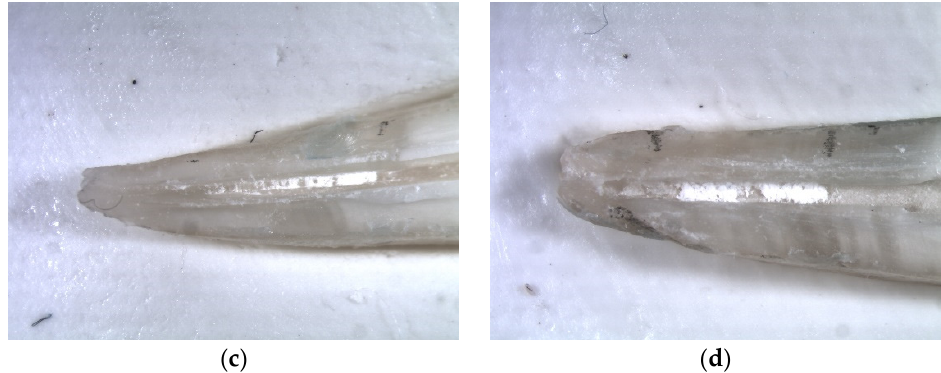
Figure 3. ( a ): Score 0: 0–25% of the groove filled with debris; ( b ) Score 1: 26–50% of the groove filled with debris; ( c ): Score 2: 51–75% of the groove filled with debris; ( d ) Score 3: 76–100 of the groove filled with debris.